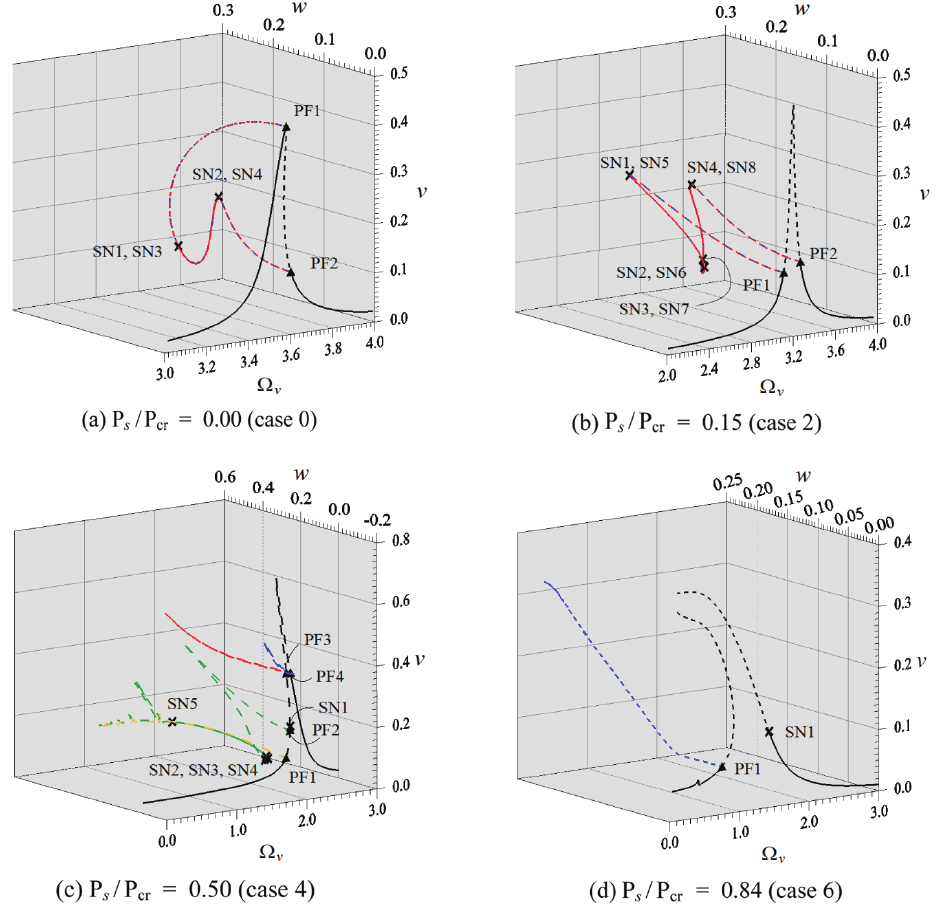
Fig. 15. Bifurcation diagram in the v − w − Ω v space, considering the axial static load and taking the lateral harmonic excitation frequency as control